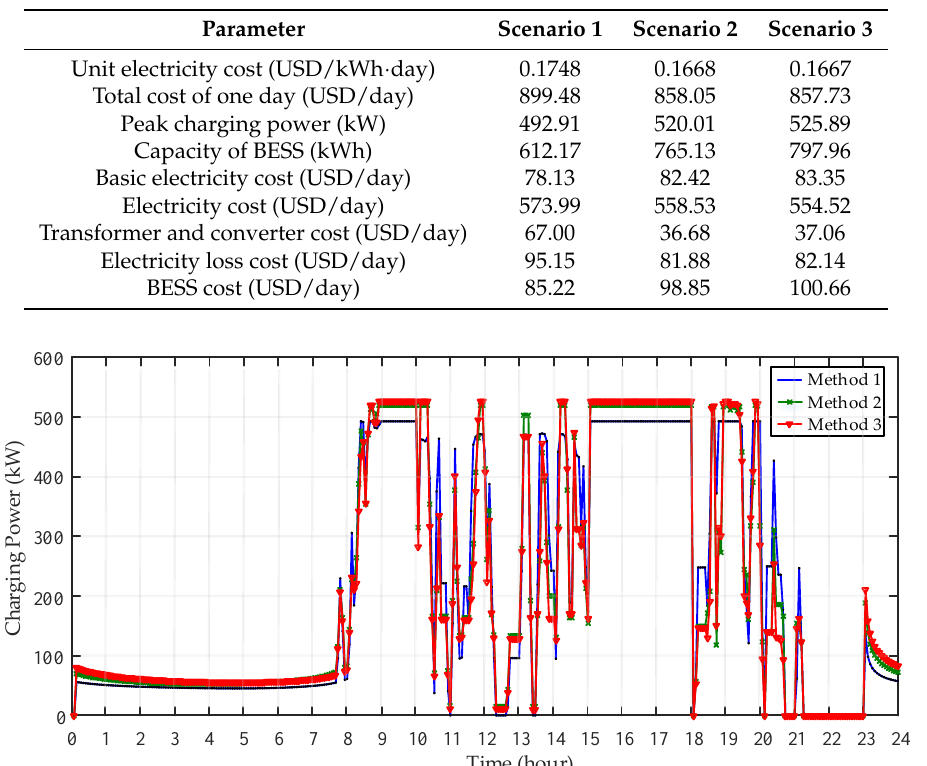
Figure 5. Load regulation performances of the three BESS configuration Scenarios.